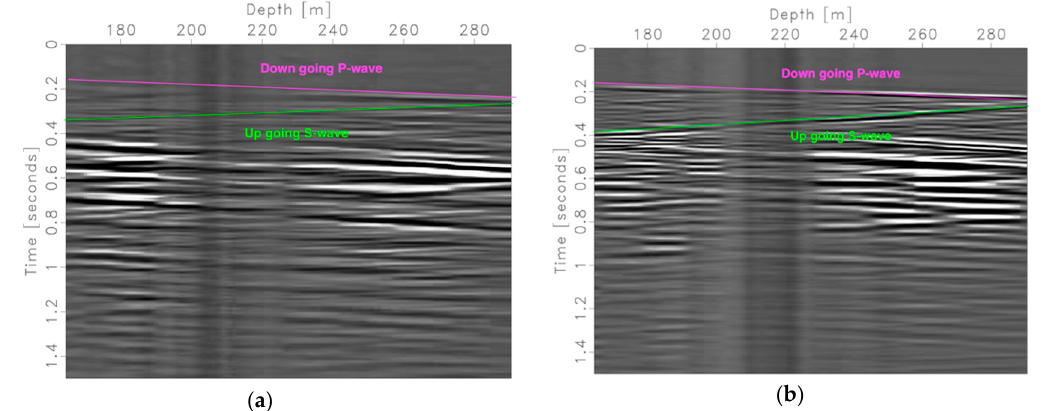
Figure 3. DAS data for vibe shots ( a ) 199 and ( b ) 125, approximately 150 m away from the well but with azimuths 180° apart.